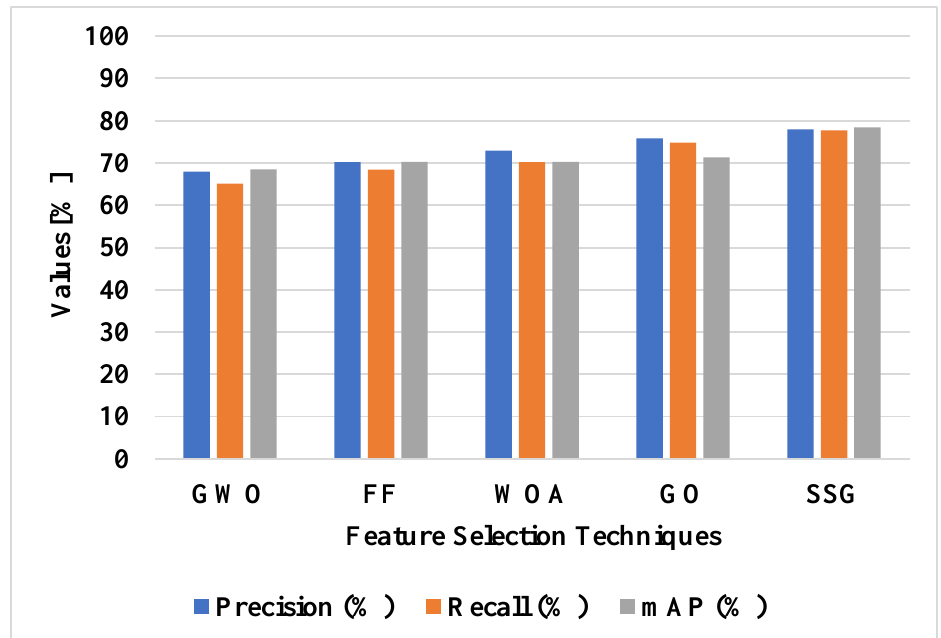
Figure 9. Performances of feature selection techniques on the DIOR dataset.